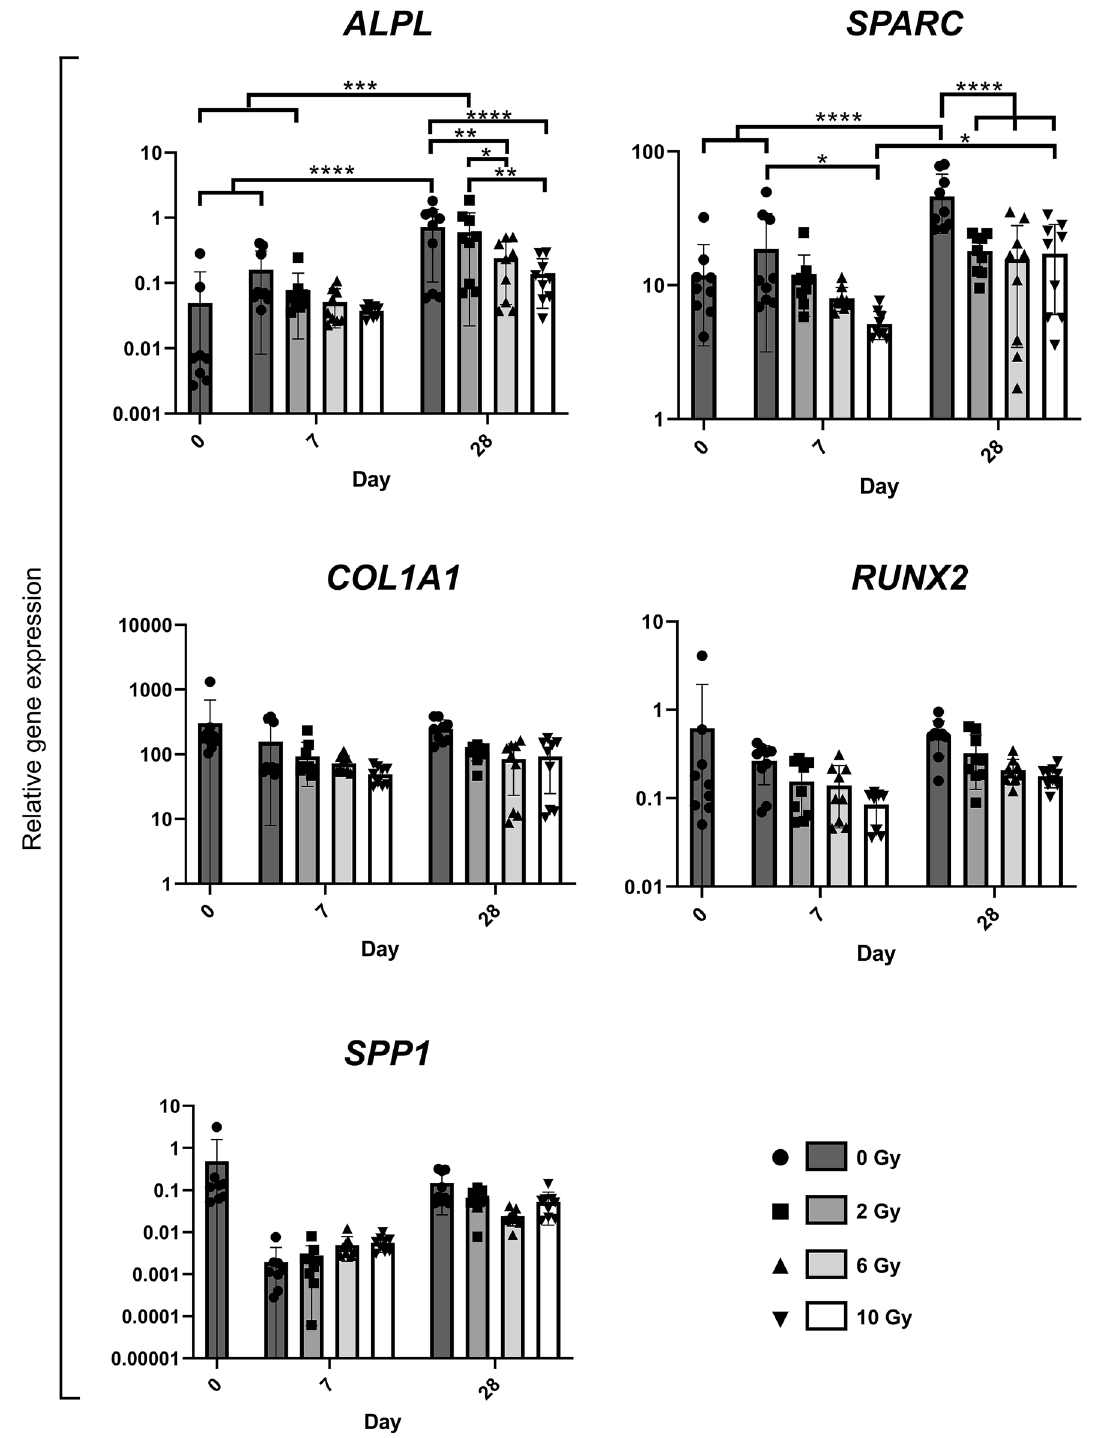
Figure 7. Marker gene expression of irradiated JHOBs. Relative gene expression of the osteoblast differentiation markers ALPL, COL1A1, RUNX2, SPARC, and SPP1 were cultivated in osteogenic medium and analyzed on days 0, 7 and 28. Expression was normalized to UBE2D2 expression. * = P < 0.05. ** = P < 0.01. *** = P < 0.001. **** = P < 0.0001. Data are presented as mean ± s.d. n = 3 donors, where three biological replicates were analyzed for each